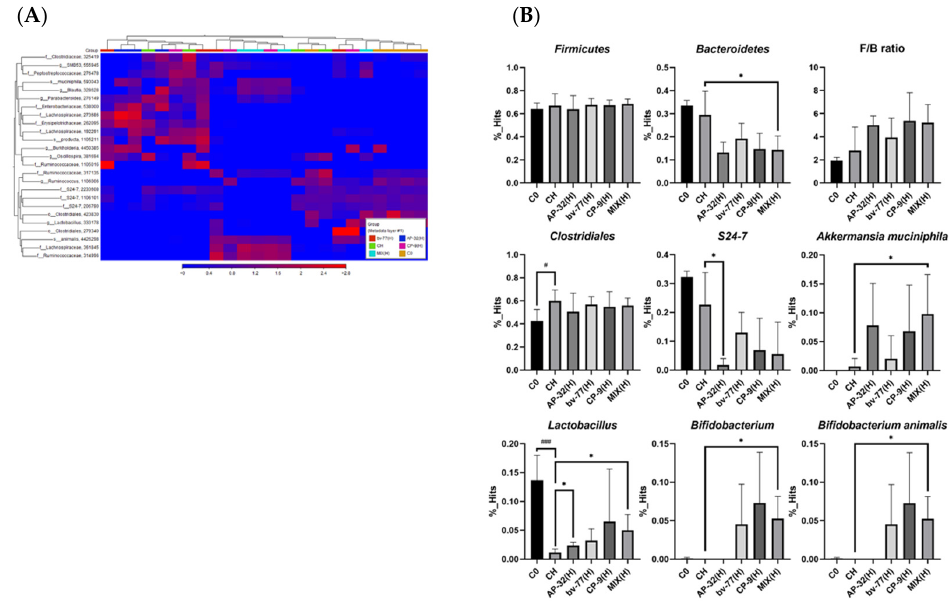
Figure 5. Core gut microbiota were altered by 8-week probiotic treatments. Core microbiota were determined by the heatmap analysis based on the operational taxonomic unit (OTU) tables. ( A ) Rows represent the 25 bacterial genera that were significantly enriched either in the control or probiotic-treated rats. Columns represent the 24 samples of the control and probiotic-treated rats. ( B ) Bar graphs showing relative abundance changes in core microbiota from the heatmap biplot analysis. F/B ratio: Firmicutes -to- Bacteroides ratio. Data show the mean ± SD of each group. Statistical anal- yses were performed by using the Student’s t-test. Statistical difference was shown as a comparison between the C0 and CH groups (# p < 0.05 and ### p < 0.001) or the CH and probiotic groups (* p <